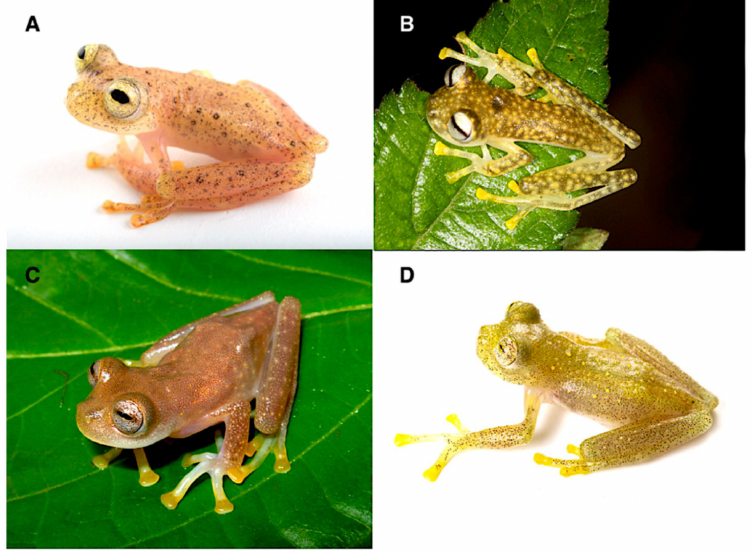
Figure 185. Glassfrog species similar to Nymphargus sucre [276]. ( A ) Nymphargus anomalus , QCAZ 47507; photo by Luis A. Coloma. ( B ) N. colomai sp. nov., QCAZ 41590; photo by Juan M. Guayasamin. ( C ) N. rosada , photo by M. Rivera. ( D ) N. sucre , MZUTI 1421; photo by A. Arteaga / Tropical